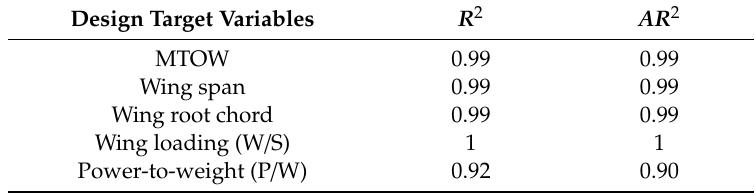
Table 3. Coe ffi cient of determination and adjusted R-squared of response surface equation (RSE).